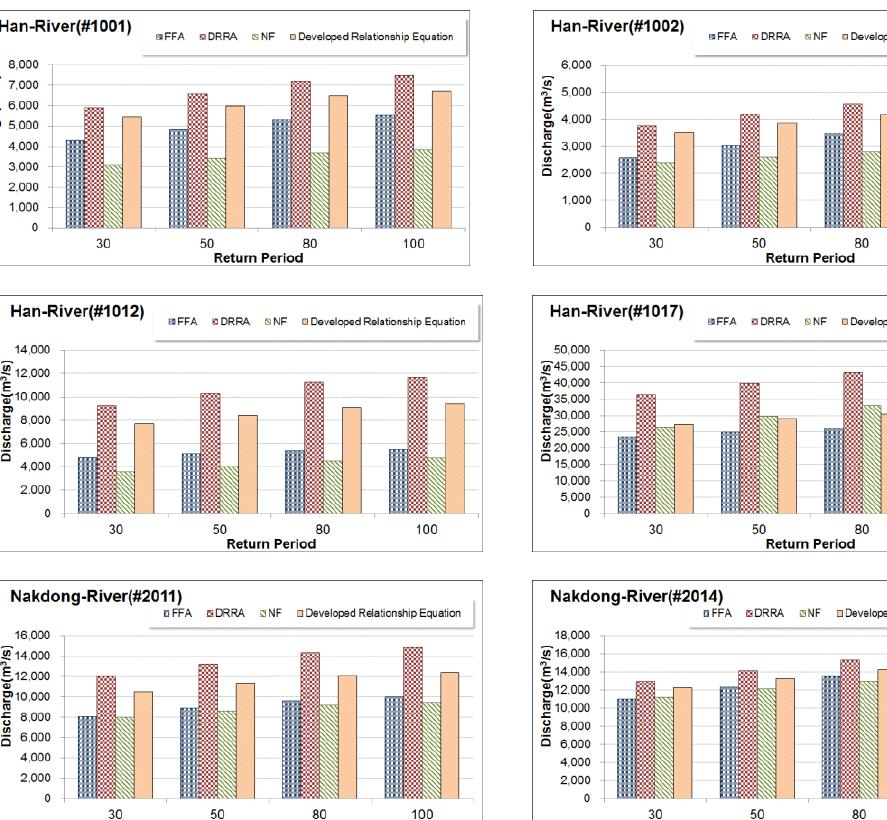
Figure 2. Study flow chart.